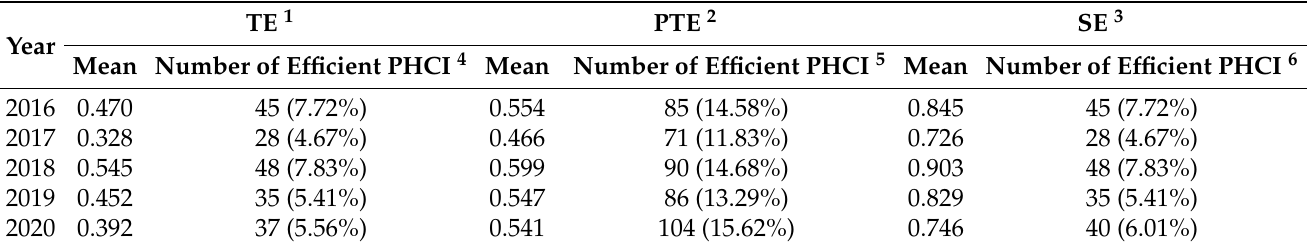
Table 4. The efficiency of Primary Health Care Institutions (PHCI) in Shenzhen, China, from 2016 to